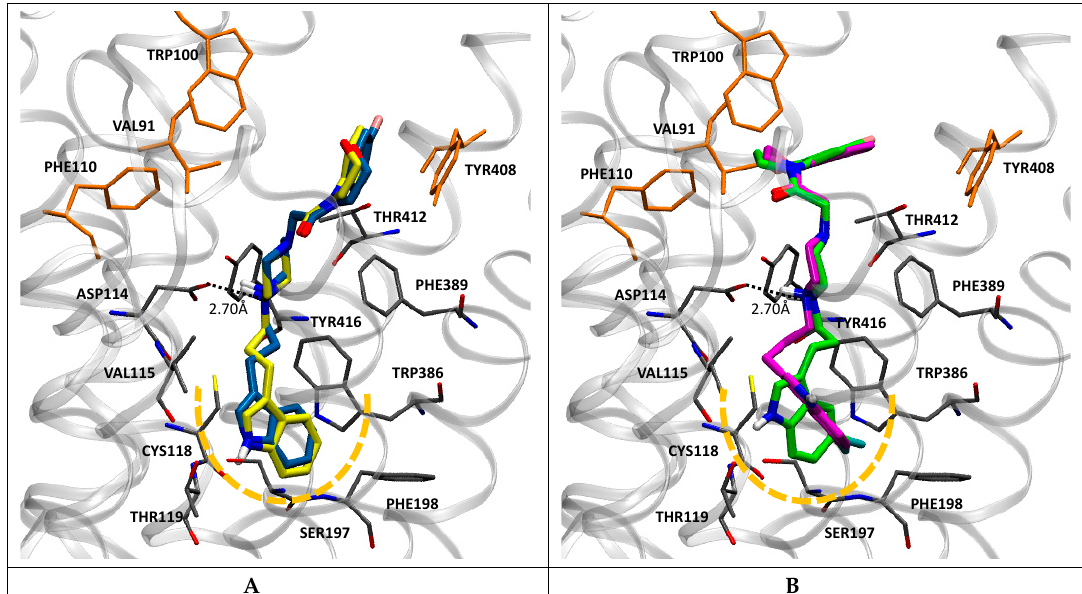
Figure 3. Docking poses in D 2 obtained for compounds 7a in yellow and 7b in blue ( A ), and compounds 7m in magenta and 7n in green ( B ). Nearby residues < 5 Å (grey sticks) are shown. Dotted lines represent ionic interactions. Yellow segmented line represents the deep hydrophobic sub-pocket. Residues lining the more external hydrophobic sub-pocket are shown in orange.